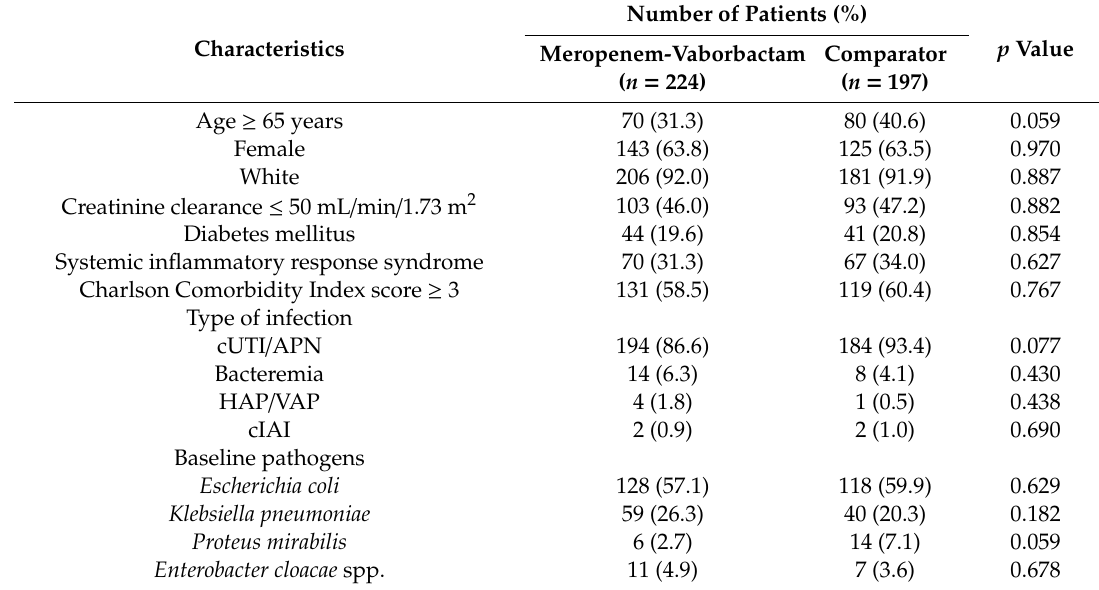
Table 1. Demographic characteristics for patients in the Targeting Antibiotic Non-Susceptible Gram-Negative Organisms (TANGO) I and TANGO II studies in the microbiologic modified intent-to-treat (mMITT)